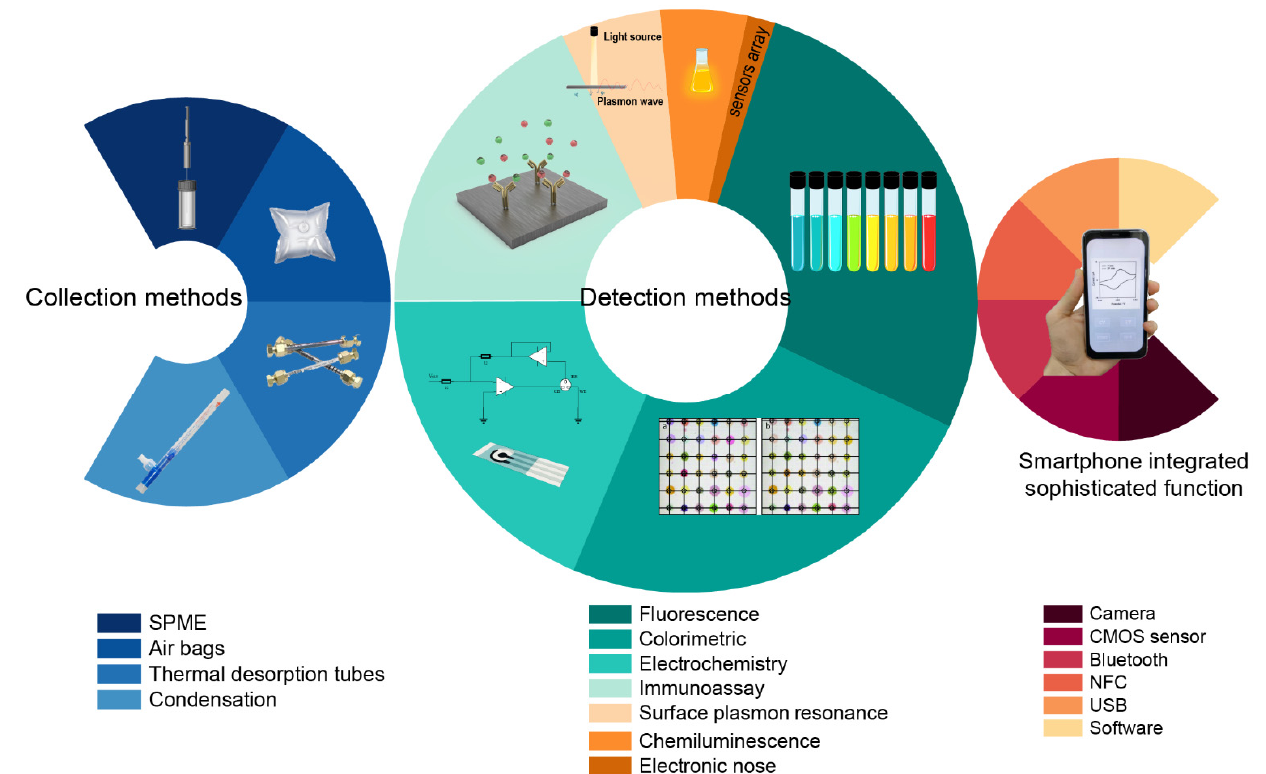
Figure 1. Schematic representation of smartphone-based biomarker detection platforms from sample collection to detection. Pie charts representing proportions of smartphone-based detection methods with different technologies.